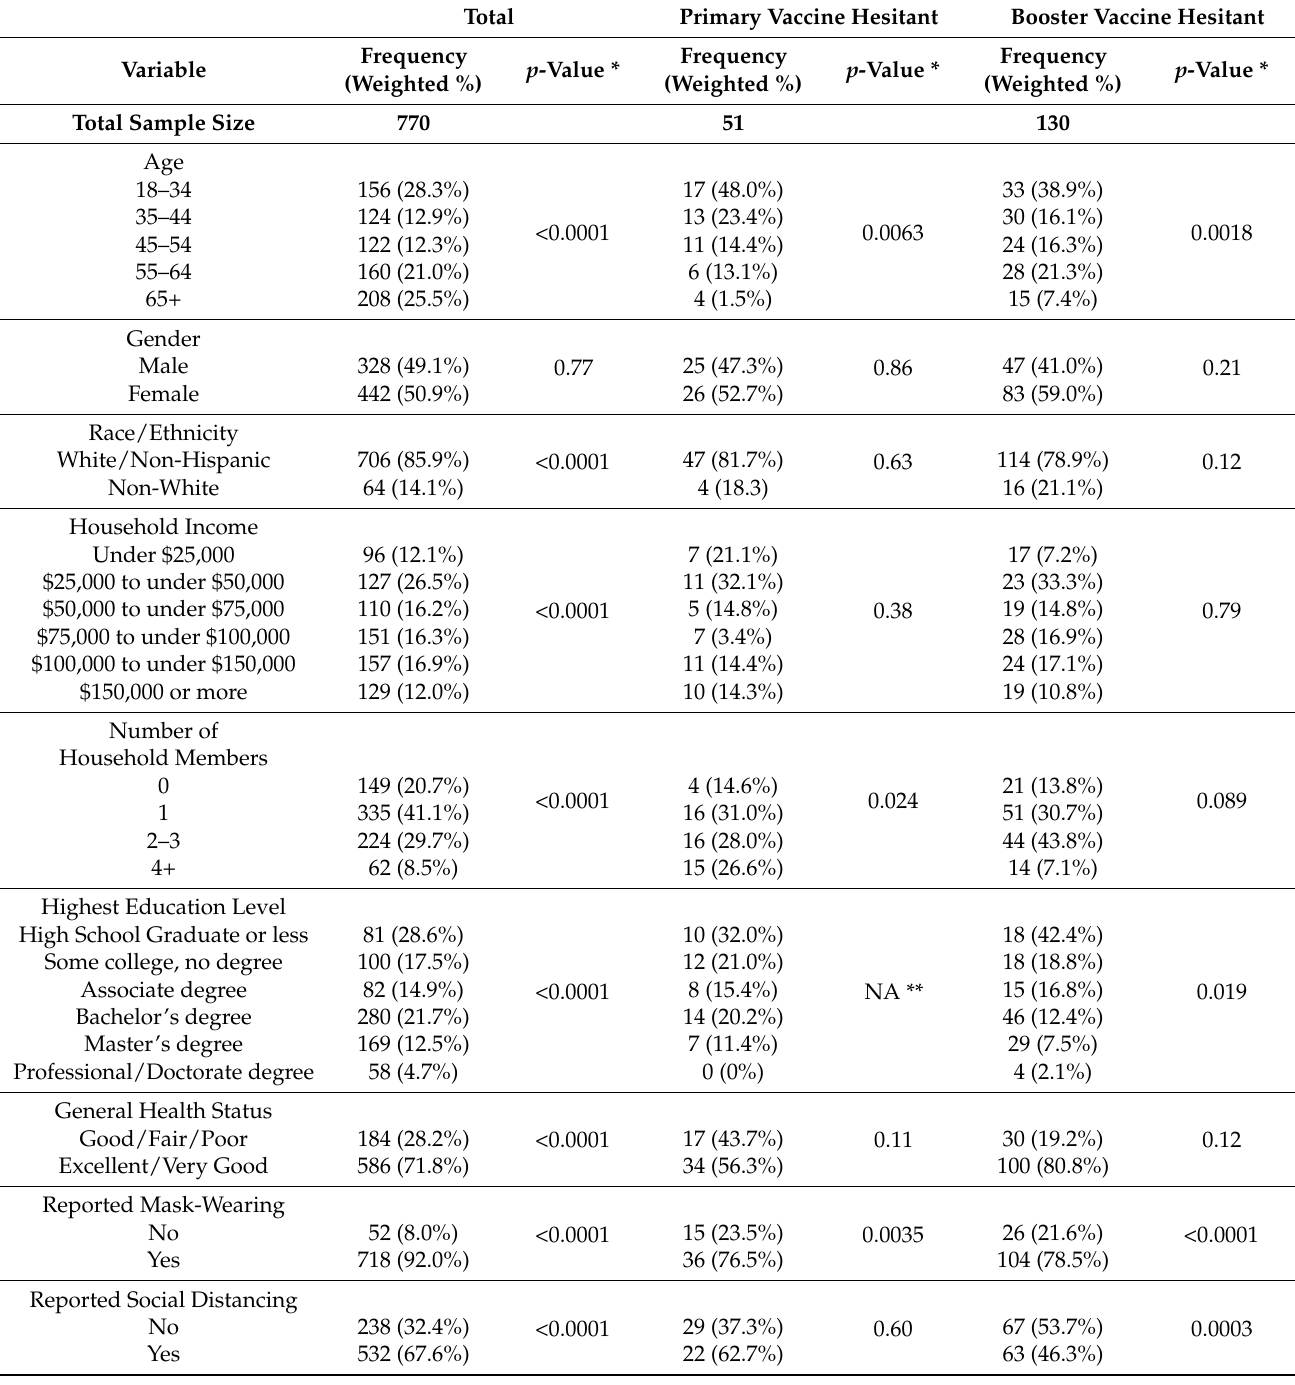
Table 1. Minnesota COVID-19 Antibody Study (MCAS) Respondent